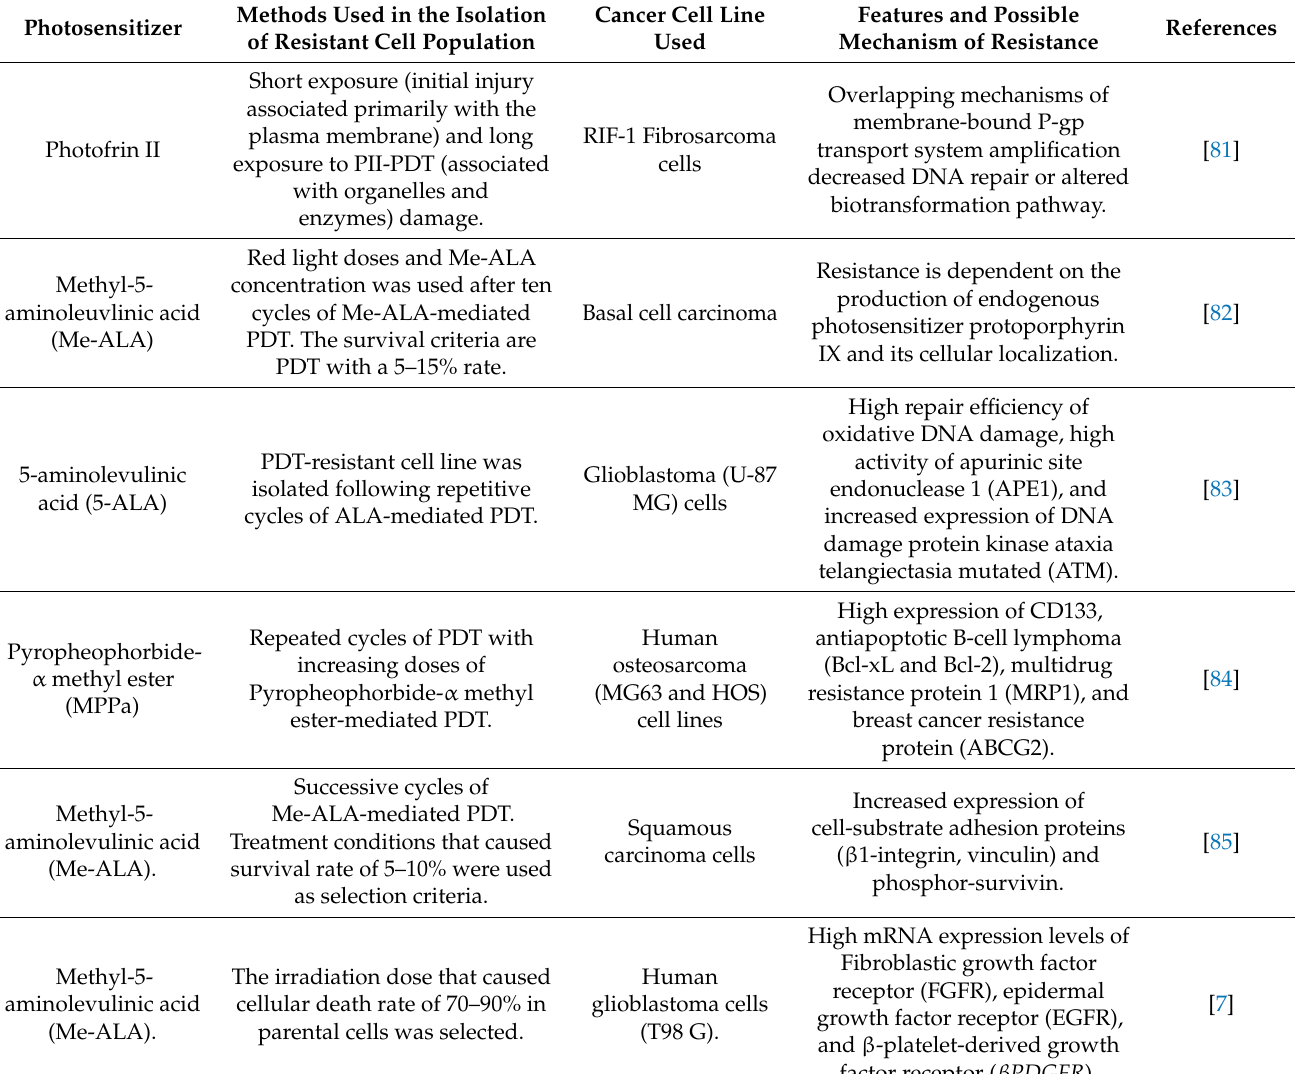
Table 1. Summary of in vitro Isolation of Cancer Cells Resistance to Photodynamic Therapy.